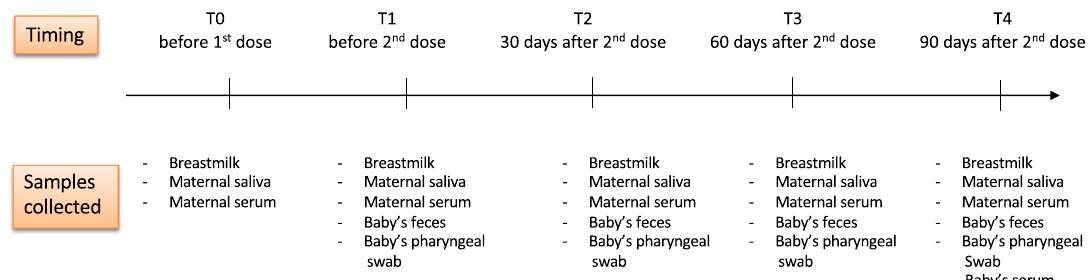
Fig. 1 Study timeline. Timing of study visits and samples collection at each visit.